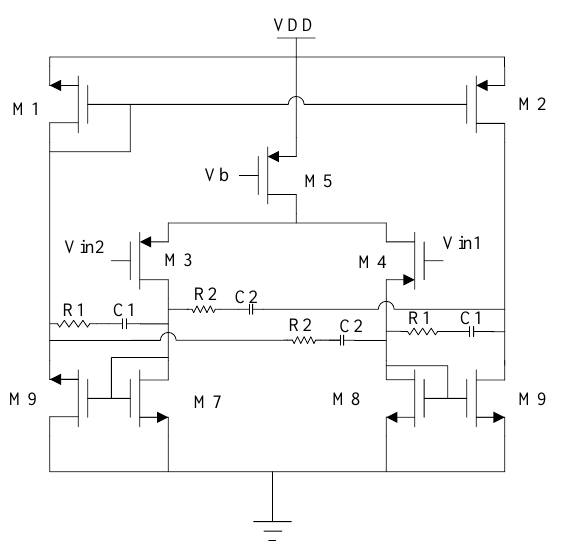
Figure 4. Current-mirror amplifier with current reuse.